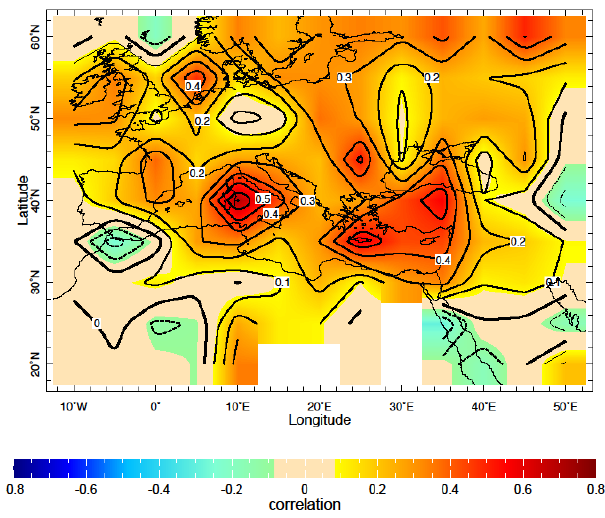
Fig. 1. Correlation, calculated for each grid cell of 5 ◦ × 5 ◦ , between the time series of DJF rainfall and cyclone counts. The cyclones were extracted from the sea level pressure daily fields of the NCEP- NCAR reanalysis project (Kalnay et al., 1996; Kistler et al., 2001). The methodology for cyclones’ detection is described in Sect. 3.1 and the rainfall is taken from the NOAA/NCEP CAMS data set (Ropelewski et al., 1984; Janowiak and Xie, 1999), which relies on observations. Correlations higher than 0.27 indicate 0.95 signif-